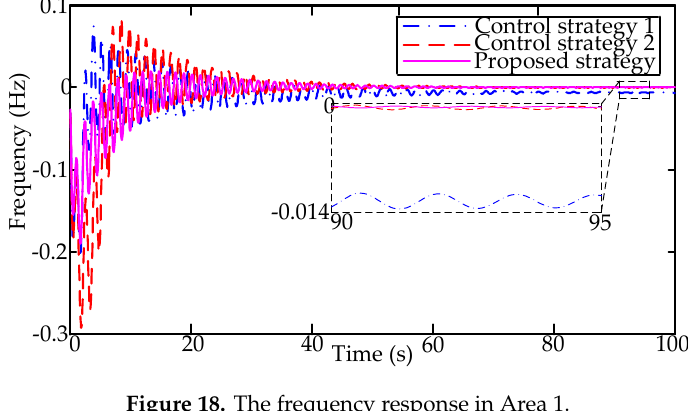
Figure 18. The frequency response in Area 1.